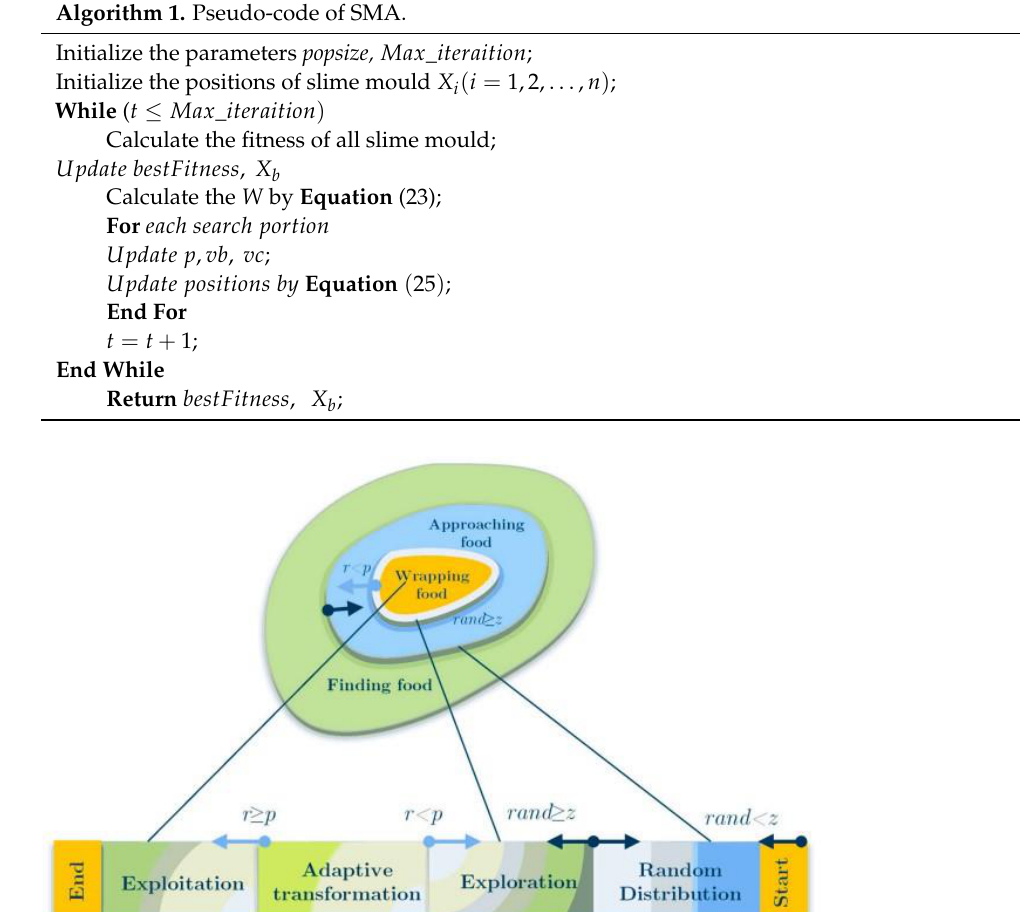
Algorithm 1. Pseudo-code of SMA.